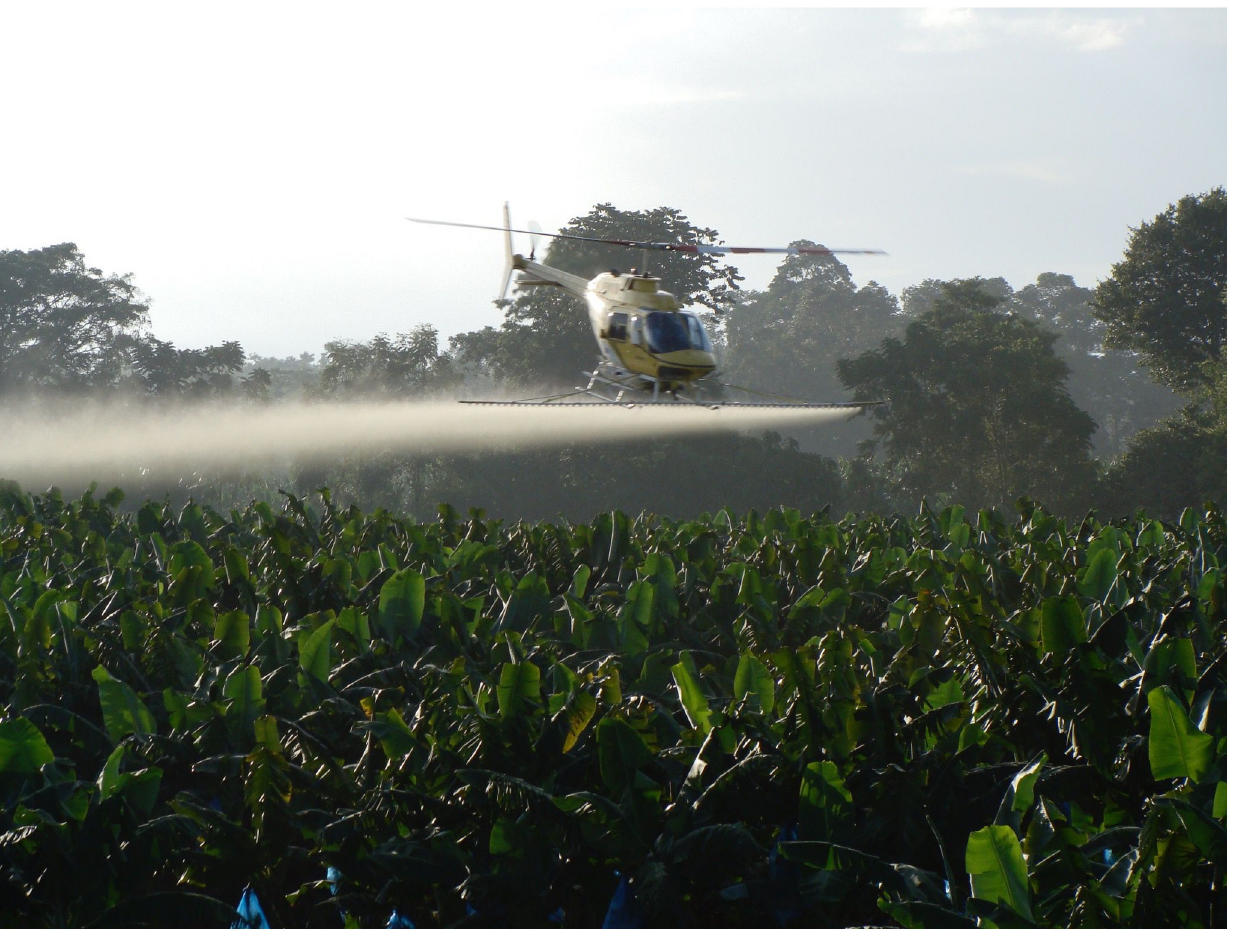
Fig 1. A spray helicopter completing a weekly fungicide application on a banana field affected by the Sigatoka disease complex in Costa Rica. As many as 50 fungicide applications can be made in a year, greatly increasing the risk of fungicide resistance in banana pathogens (photo by Gert